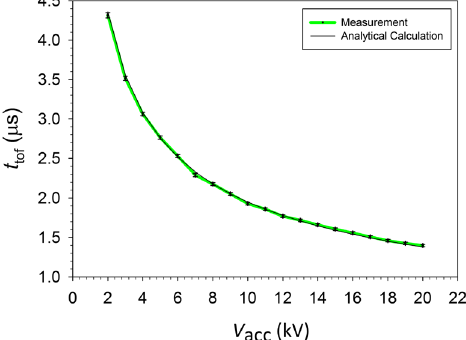
FIG. 13. Measured (green) and analytically calculated (black) time of flight t between the center of the deflection plates and tof the BCT for the He þ pulses as a function of the accelerating voltage V acc